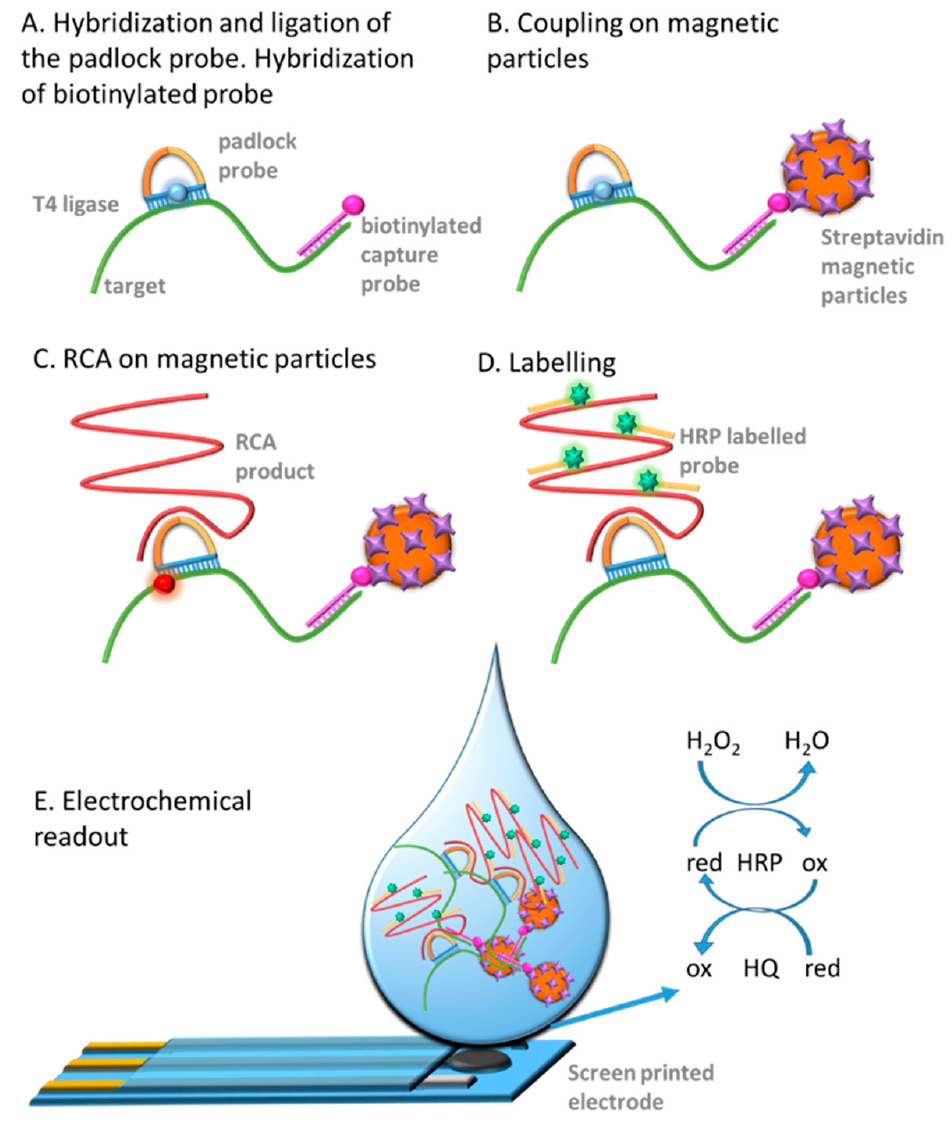
Figure 3. Schematic representation of the electrochemical genosensing for the rolling circle ampli- fication products detection on streptavidin-MP. ( A ) The biotinylated capture probe as well as the padlock probe are both hybridized to the DNA target ( B ) The DNA target is then coupled on strep- tavidin magnetic particles; ( C ) RCA on the streptavidin-MP is then performed; ( D ) Hybridization with the readout probe (HRP labelled) to achieve the electrochemical reporter is then performed; ( E ) Electrochemical readout by square wave voltammetry (SWV) upon addition of the mediator HQ and the substrate H 2 O 2 for the HRP on screen-printed electrodes.